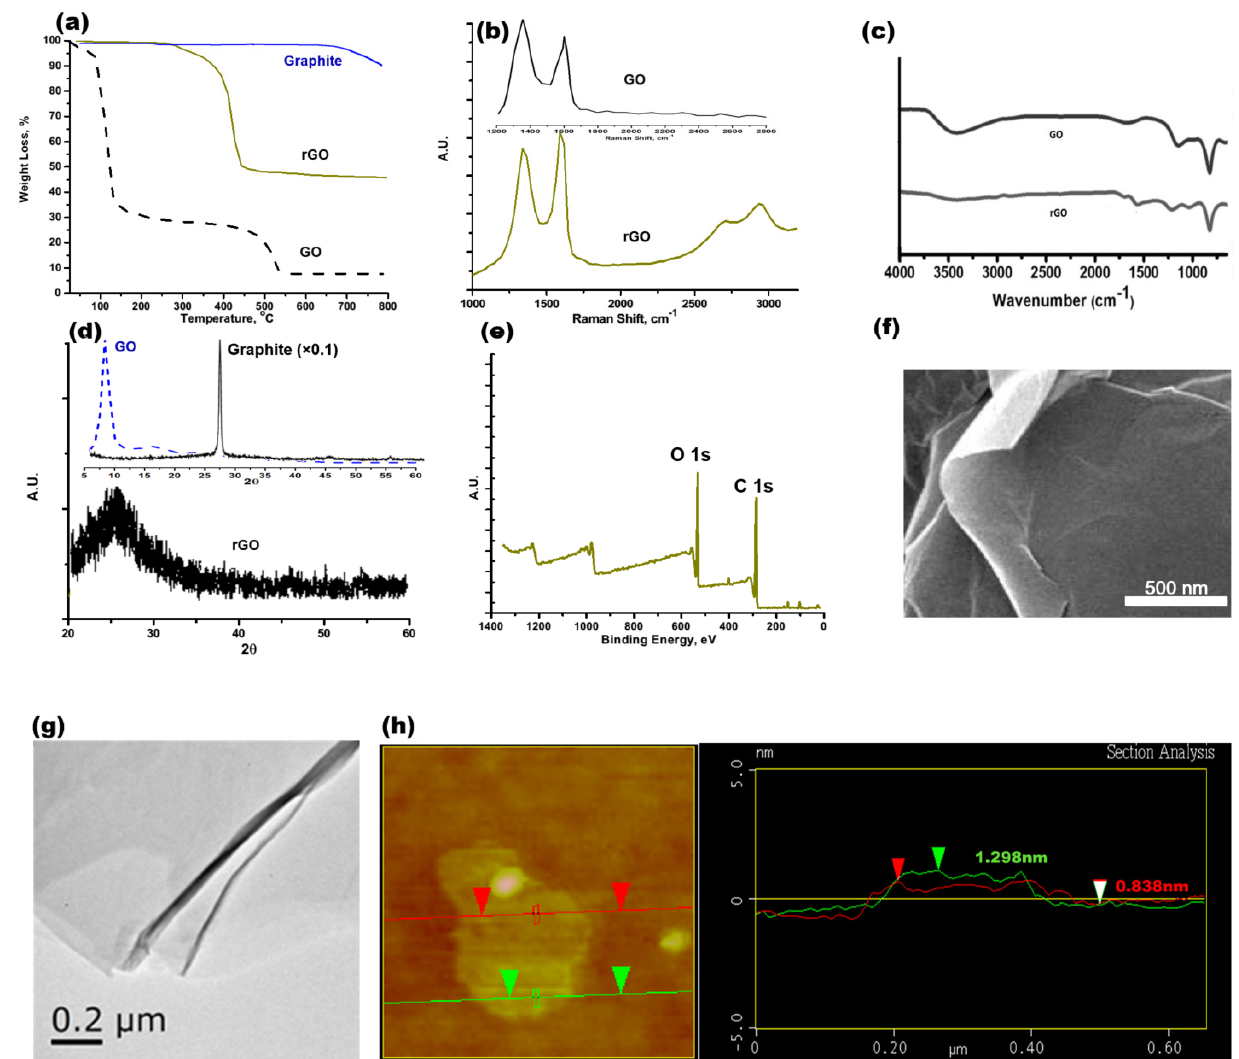
Figure 2. Characterizations of reduced graphene oxide (rGO) produced via ( a ) TGA, ( b ) Raman spectra with 532 nm laser excitation, ( c ) FTIR, ( d ) XRD, ( e ) XPS, ( f ) SEM, ( g ) TEM, and ( h ) AFM.